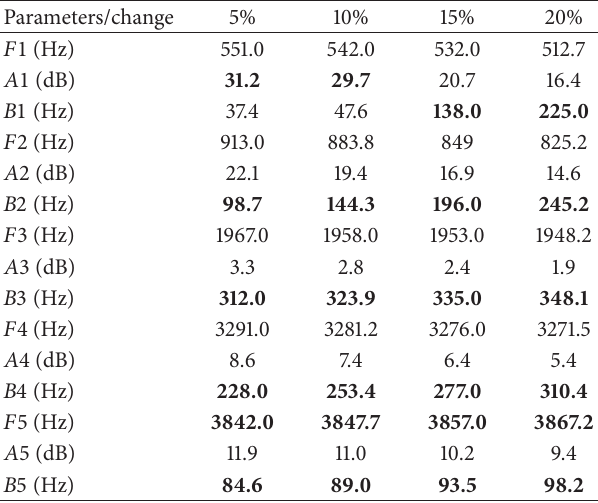
Table 2: A comparison of computed formant frequencies for child